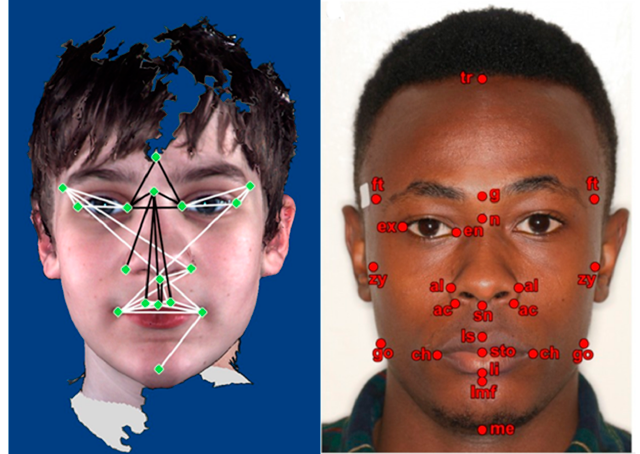
Figure 9. Image on the left [7] indicates significant facial landmark changes in boys with ASD. Image on the right [34] indicates the facial feature landmarks used in a comparative anthropometry difference study in relation to Kenyan-Africans, African Americans, and North American Whites. Statistically, normal Kenyan African women’s eye width (ex-en) in Table 16 is 33.7 mm, whereas that of NAWs is 30.7 mm, with a p -value < 0.001 (A small p -value, for example, less than 0.05 (typically ≤ 0.05), indicates a statistically significant difference. In this case, the clinically significant difference was set at ±3 mm). For African Americans (AAs), the inter-canthal distance en-en compared to NAWs was significantly longer, at 34.4 mm vs. 31.8 mm, with a p -value < 0.001 (Table 16) [34]. Table 16. Facial anthropometrics comparison of Kenyan Females with African Americans and North American Whites.